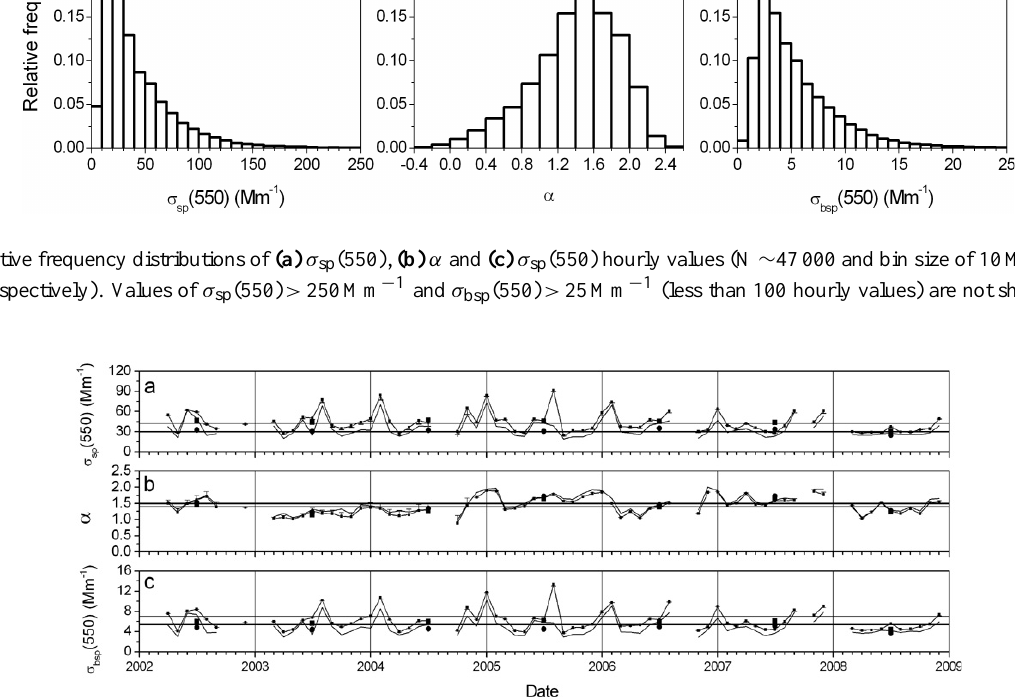
Fig. 3. Time series of mean (line with symbol) and median (line without symbol) monthly values of (a) σ sp (550), (b) α and (c) σ bsp (550). The error bars reflect the drift of the calibration constants and are added to the mean values. Annual values are represented by the black symbols (square for annual average and circle for annual median). Average (solid thin line) and median (solid thick line) values for the whole period are also depicted as horizontal lines.